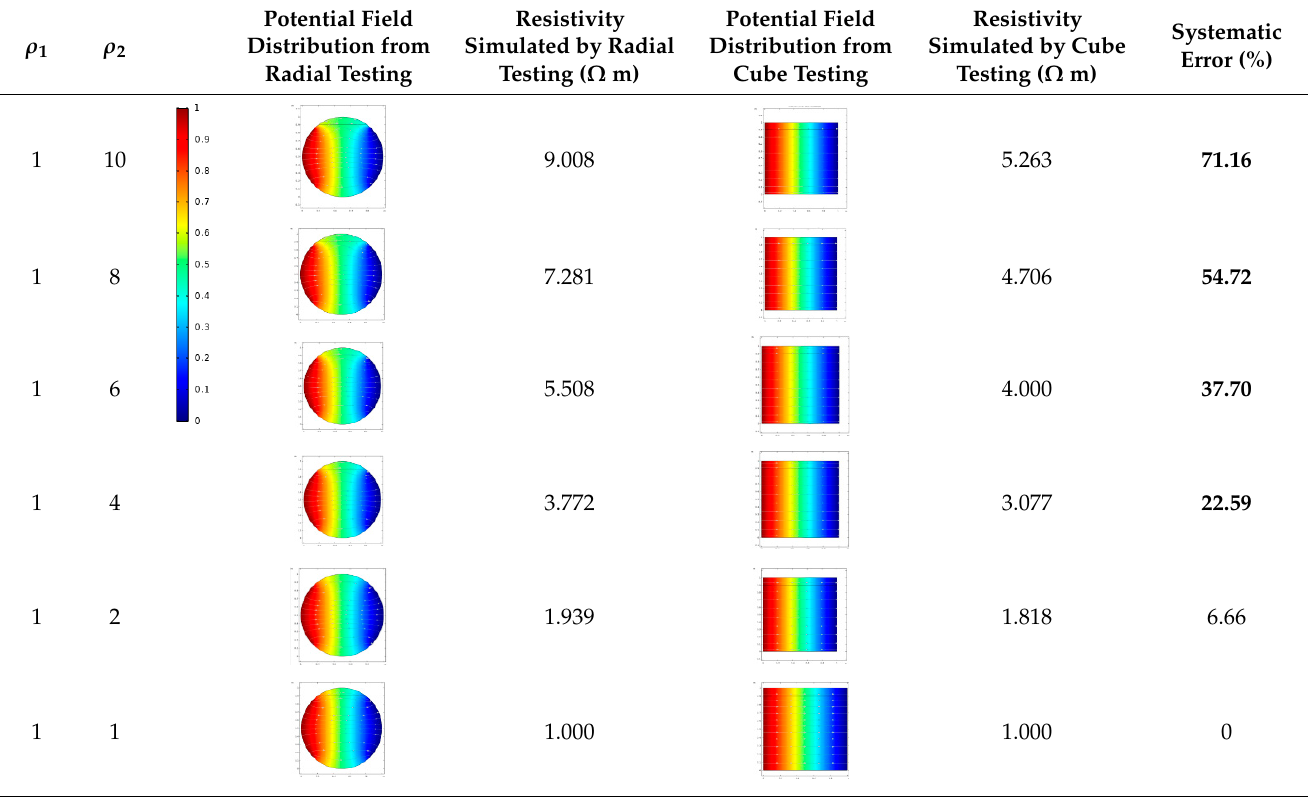
Table 8. Numerical simulation results for resistivity difference in various materials (0.3:0.7).